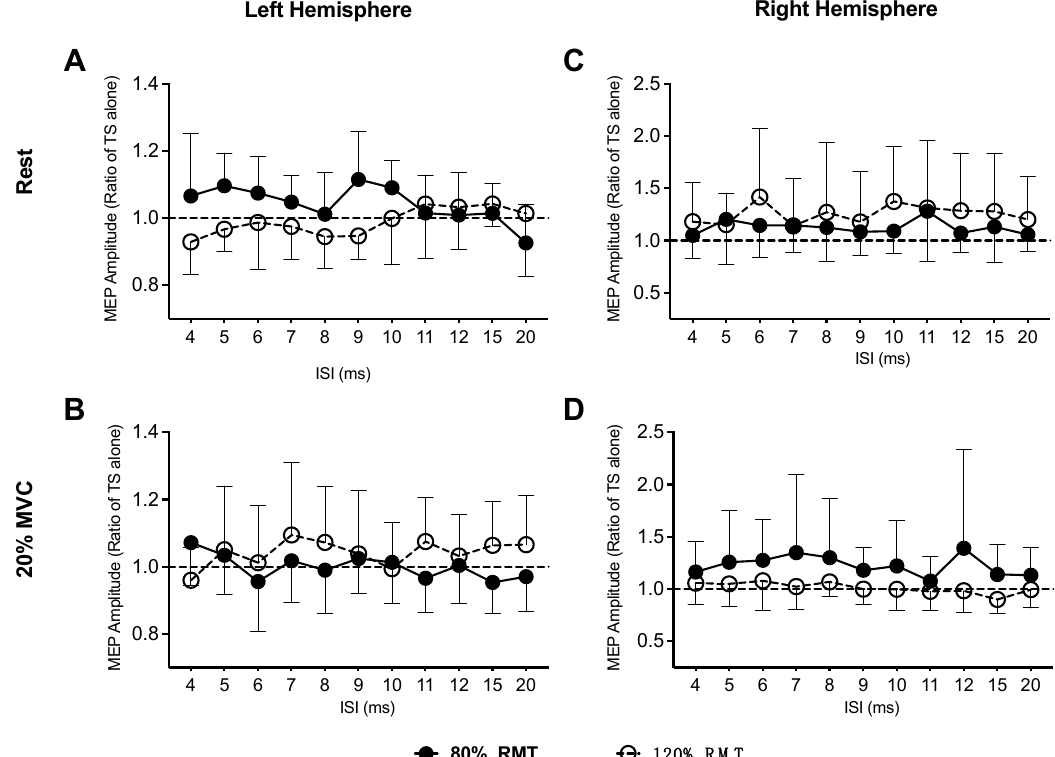
Figure 3. Normalized motor evoked potential (MEP) amplitudes for at rest condition ( A ) or during a 20% maximum voluntary contraction (MVC) of the target muscle ( B ) in the left hemisphere and at rest condition ( C ) or during a 20% MVC of the target muscle ( D ) in the right hemisphere. Ratios below one represent inhibition, whereas ratios above one denote facilitation. Results revealed that MEP amplitudes were not significantly inhibited nor facilitated at both CS intensities and all ISIs. Error bars represent 95% confidence intervals.